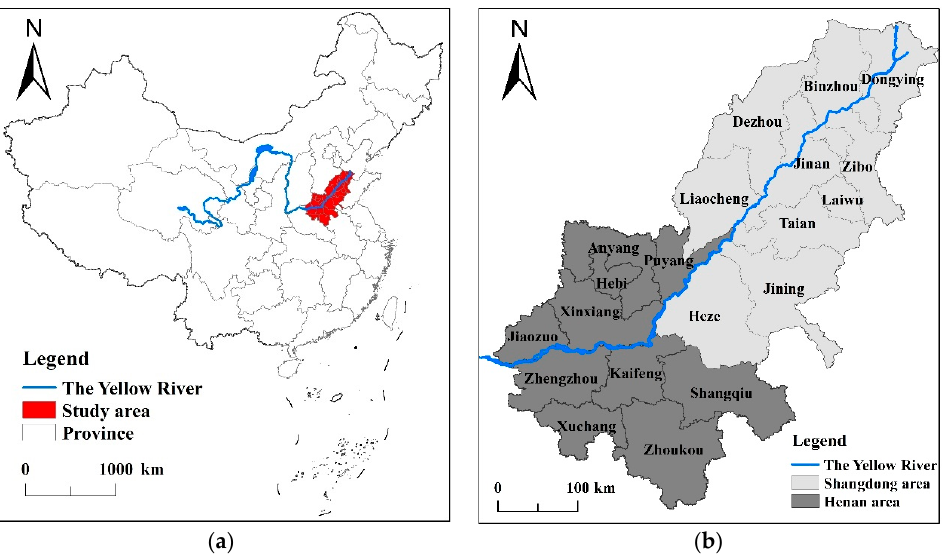
Figure 1. Map showing the study area, Henan and Shandong Provinces, and the Yellow River. ( a ) Location of the study area with China, ( b ) map of Henan and Shandong Provinces.